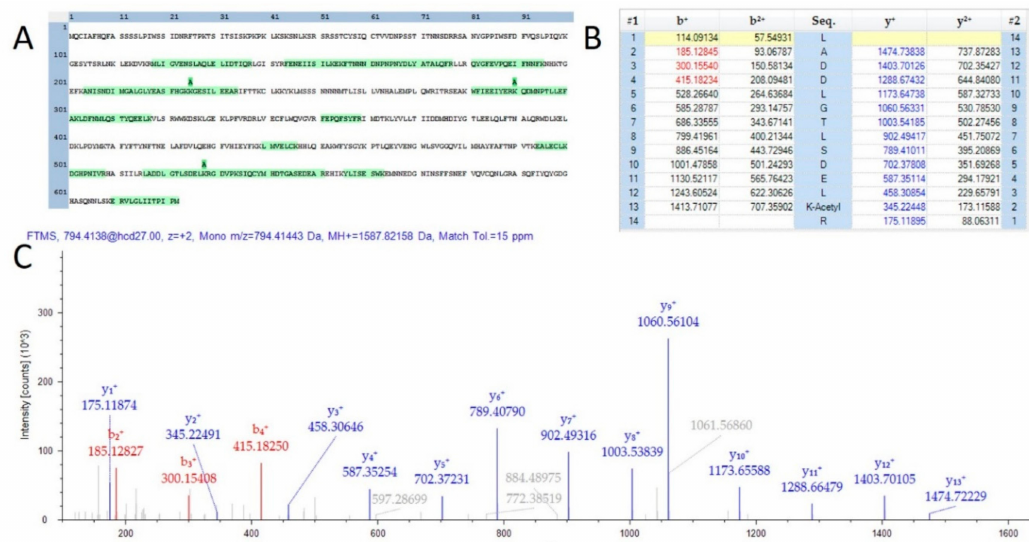
Figure 3. Evidence of acetylation on TPS1. ( A ) A sequence map demonstrating 3 observed lysine acetylation modifications. ( B ) A fragment map showing 100% sequence coverage for one acetylation site. ( C ) MS / MS spectra matching the fragment